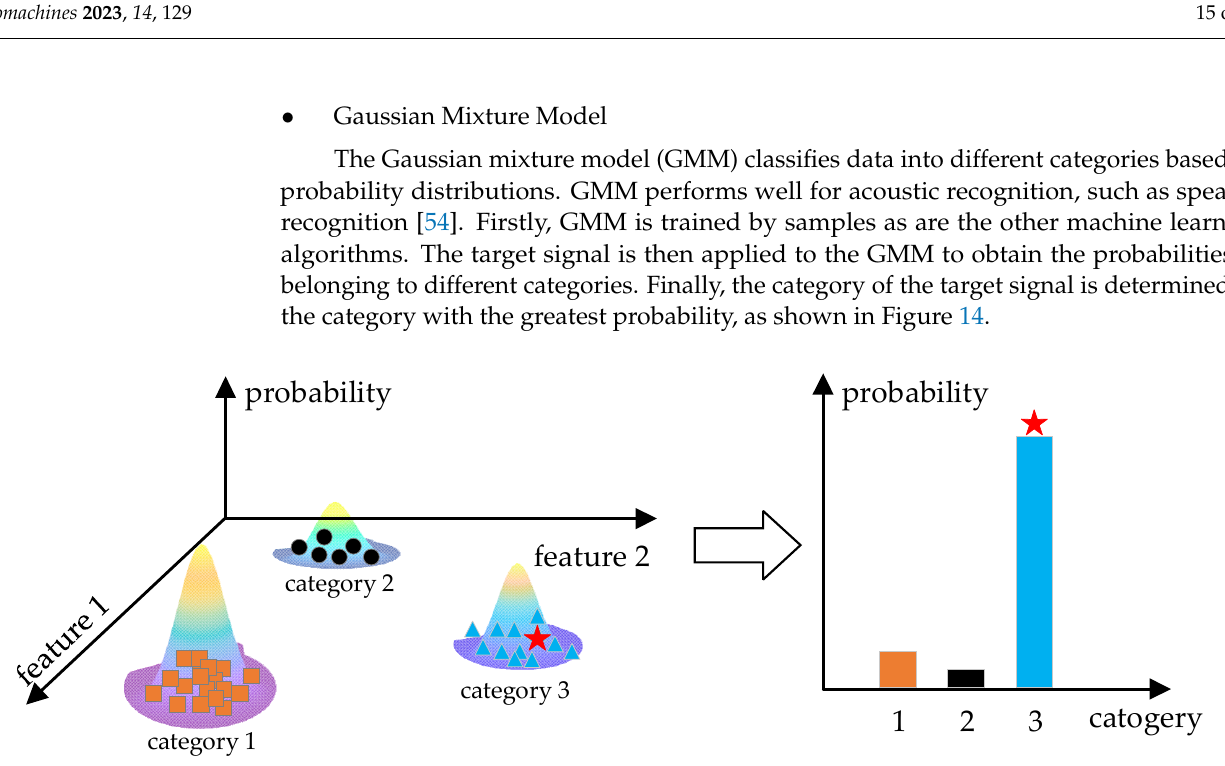
Figure 13. Neural network classification.